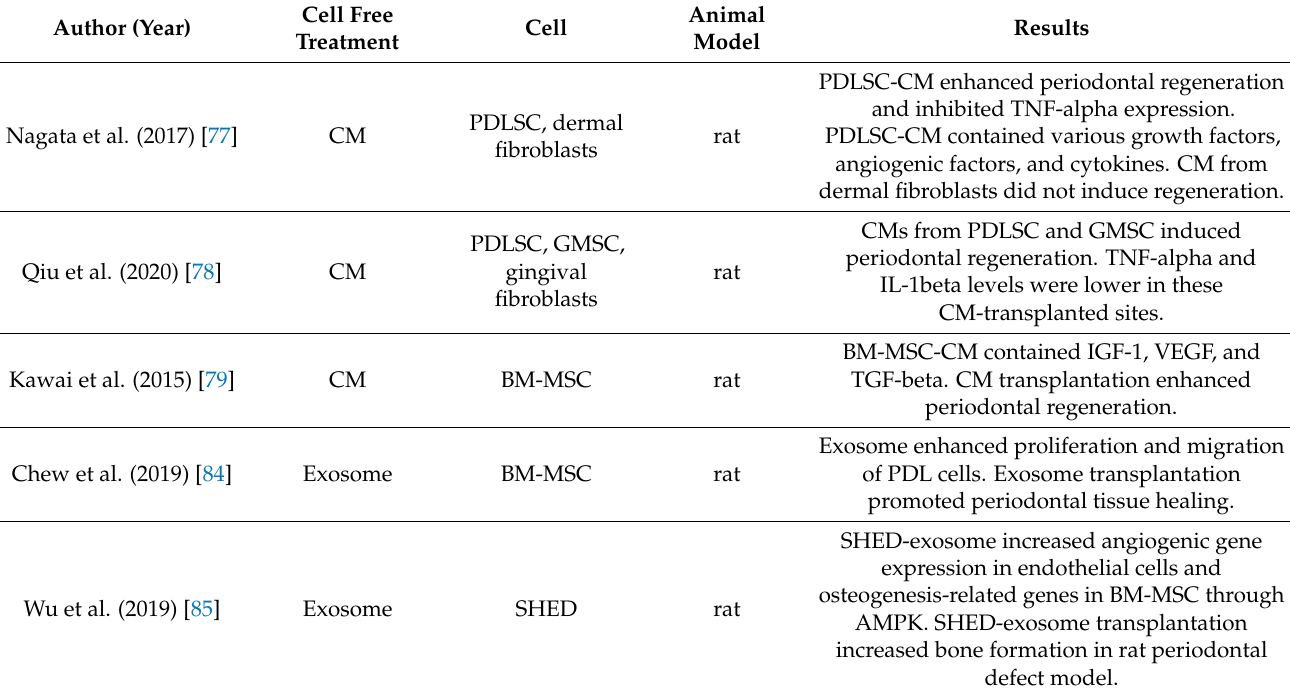
Table 3. List of animal studies of cell-free treatment for periodontal